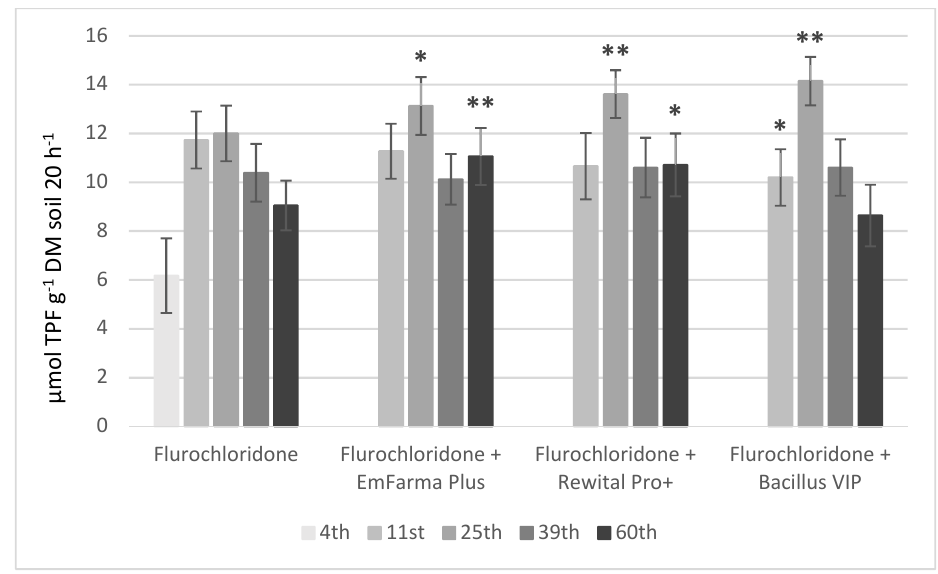
Figure 6. Changes in the DHA of the soil with flurochloridone and following application of formulations with EM in time. Statistically significant p values are shown as p < 0.05 (*) and p < 0.01 (**).